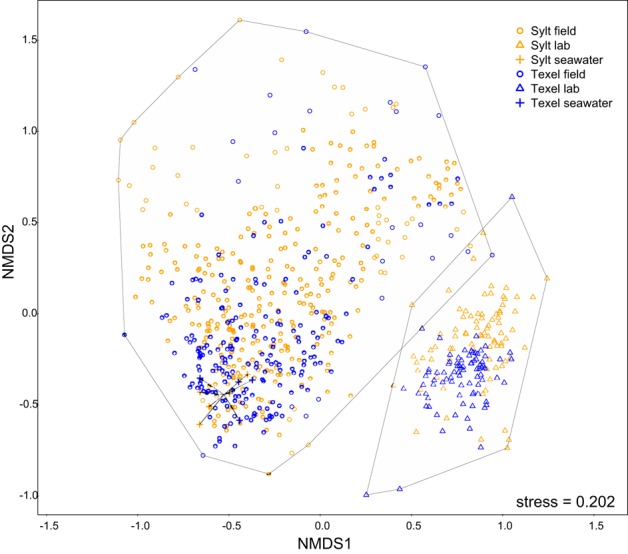
NMDS plot (Bray-Curtis) depicting variability within the complete dataset (all seawater and hemolymph samples). Hulls enclose laboratory and field samples, respectively.